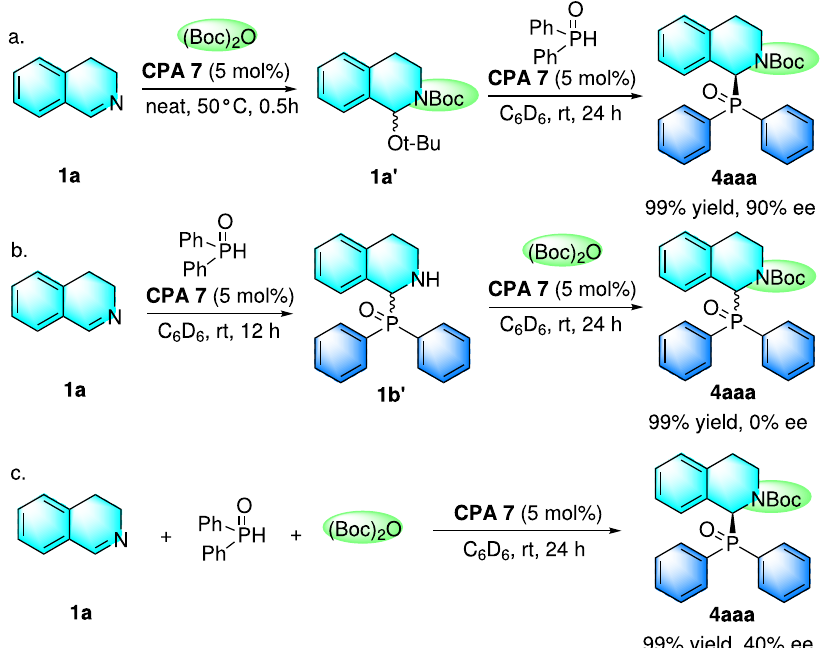
Fig. 5 Control and NMR tracking experiments. a Control experiment to verify the intermediate 1a ’ ; b Control experiment to exclude the intermediate 1b ’ ; c Control experiment to show the reaction running in a stepwise manner.